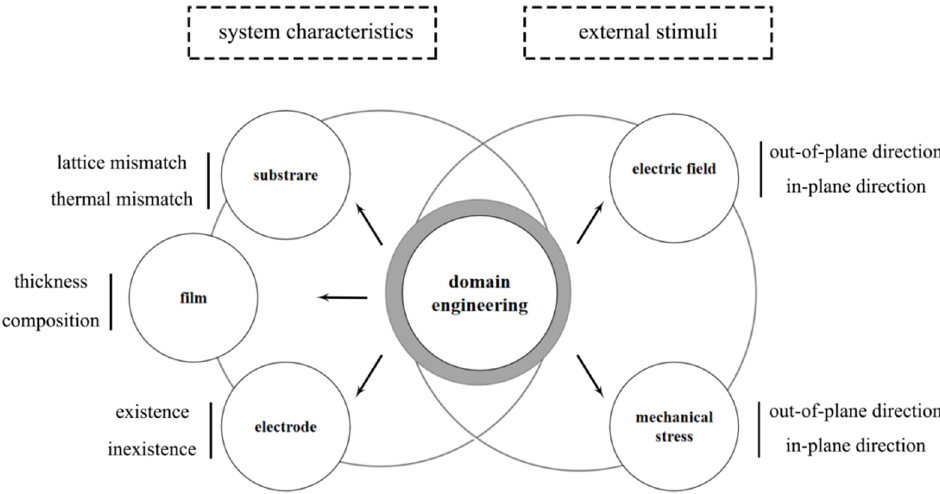
Figure 14. A schematic of suggested domain engineering